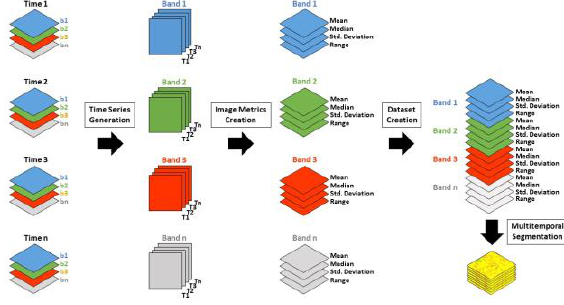
Figure 7. Detailed methodological approach flow